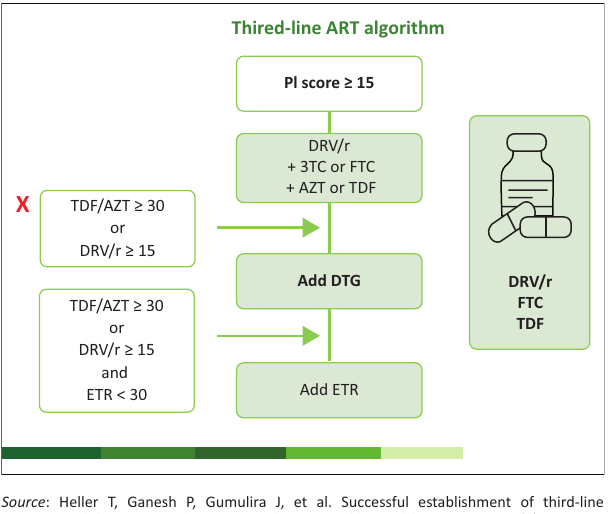
Thired-line ART